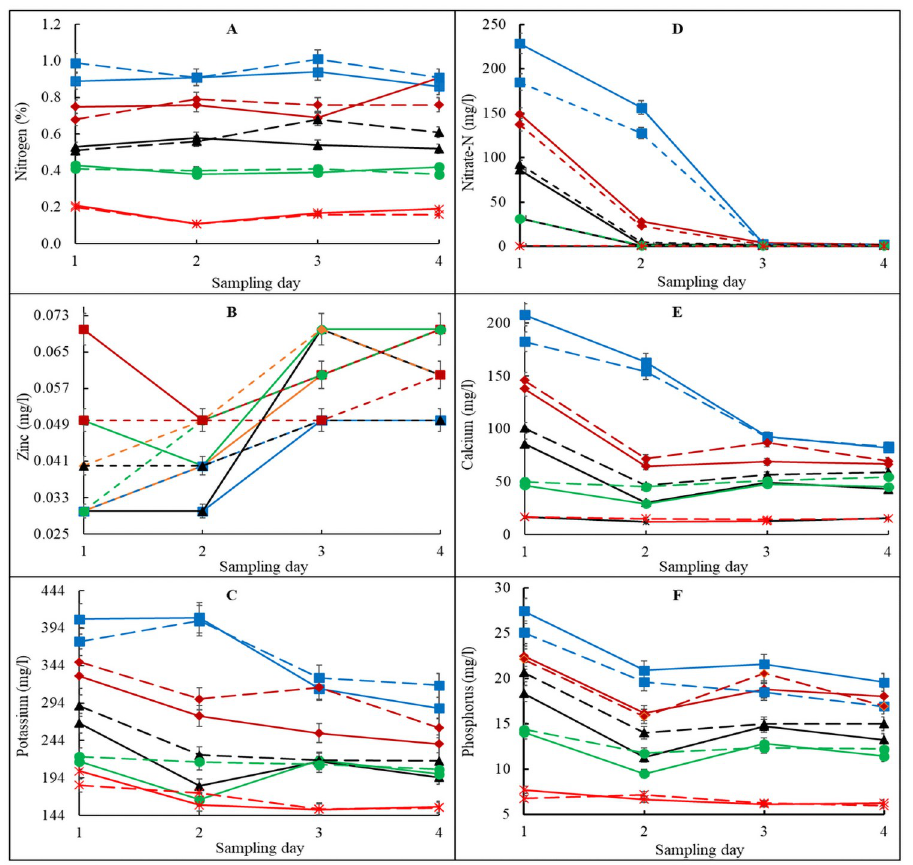
Fig 3. Nitrogen (A), zinc (B), potassium (C), nitrate-nitrogen (D), calcium (E) and phosphorus (F) availability in vermicast-sawdust mixed media without (solid lines) and with (broken lines) addition of Trichoderma viride during a 90-day incubation period. A1, B1 (blue line) is 80%vermicast+20%sawdust; A2, B2 (brown line) is 60% vermicast+40%sawdust; A3, B3 (black line) is 40%vermicast+60%sawdust; A4, B4 (green line) is 20%vermicast+ 80% sawdust; and A5, B5 (red line) is sawdust alone. Day 0 (point 1); day 30 (point 2); day 60 (point 3) and day 90 (point 4) with n = 3 per experimental replicate. Error bars represent standard